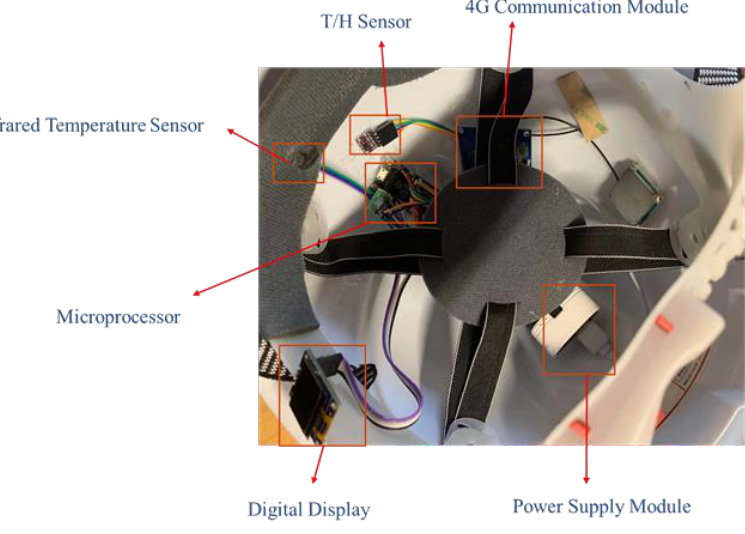
Figure 1. Structure of smart helmet system.